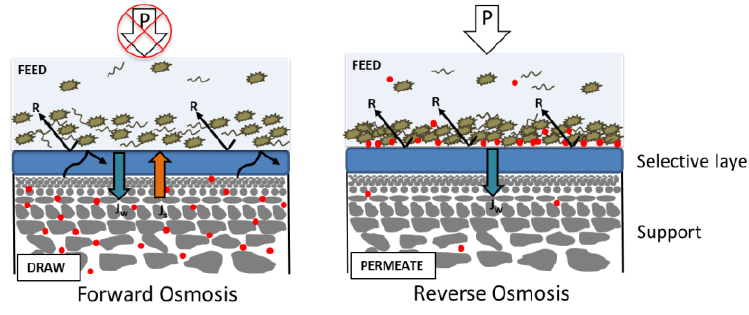
Figure 2. Schematic of fouling in forward osmosis (FO) and reverse osmosis (RO) processes.